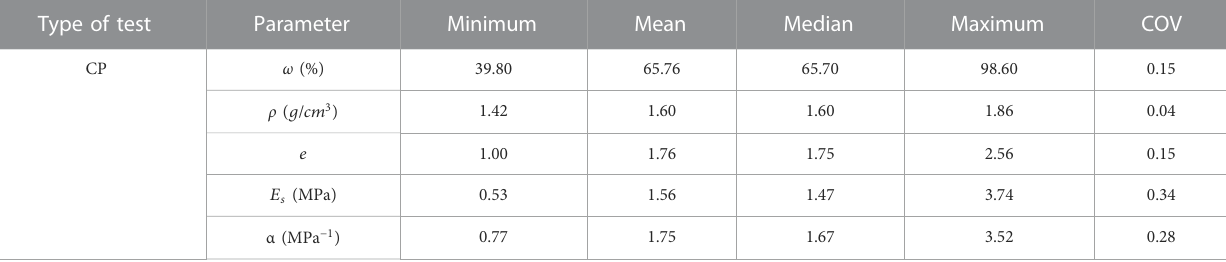
TABLE1Summaryoftheminimum, mean,median,maximum,andCOVvaluesforthephysical( ω ; ρ ,e)andmechanical (E s ; α )parameters takenfromthedatabase. Type of